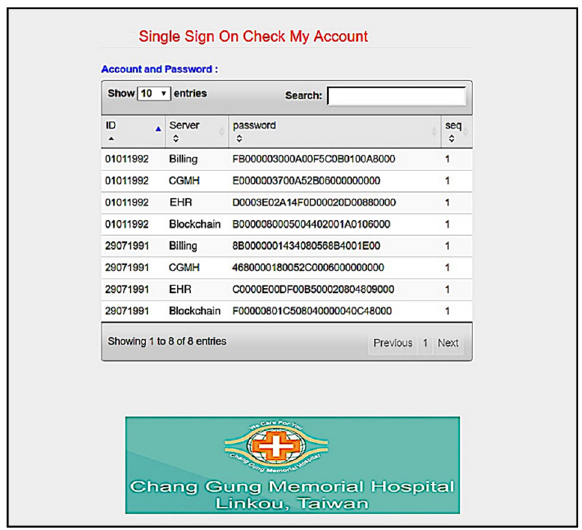
Figure 12. Registration with specific server.